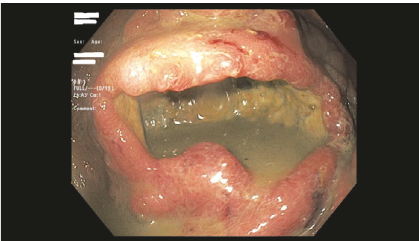
Figure 1: Gastric ulcer with feculent material.